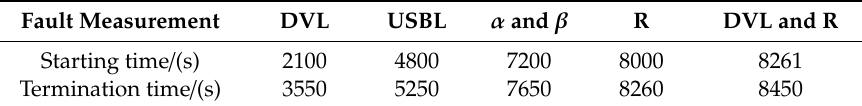
Table 6. The starting and termination times of measurement fault